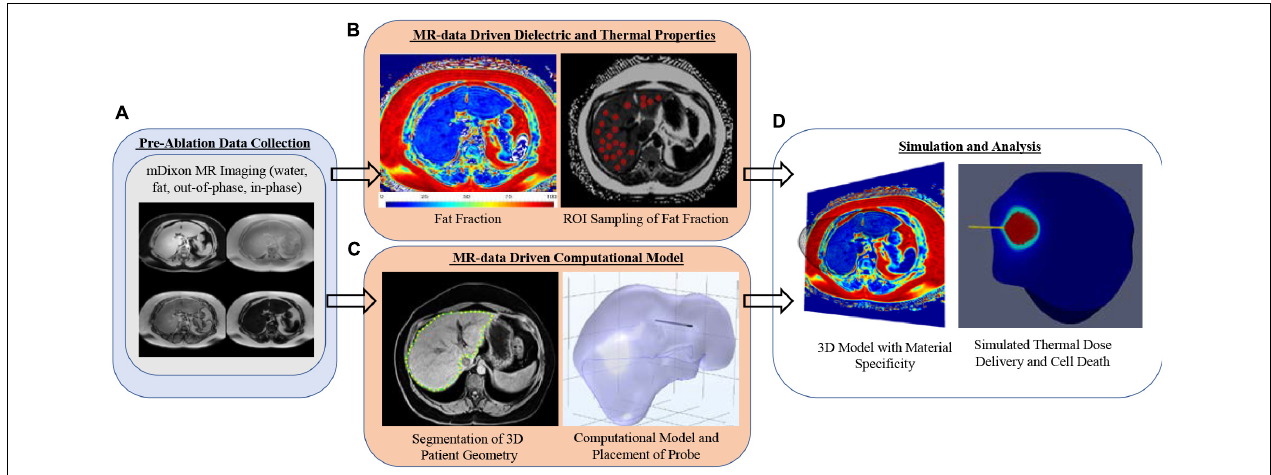
FIGURE 1 | Analysis overview with (A) mDIXON MR imaging, (B) fat fraction region-of-interest sampling strategy, (C) patient-specific computational models with implanted microwave probe, and (D) realization of 3D MR-Data-driven patient-geometry-/patient-material- specific computational model with simulated microwave ablation.